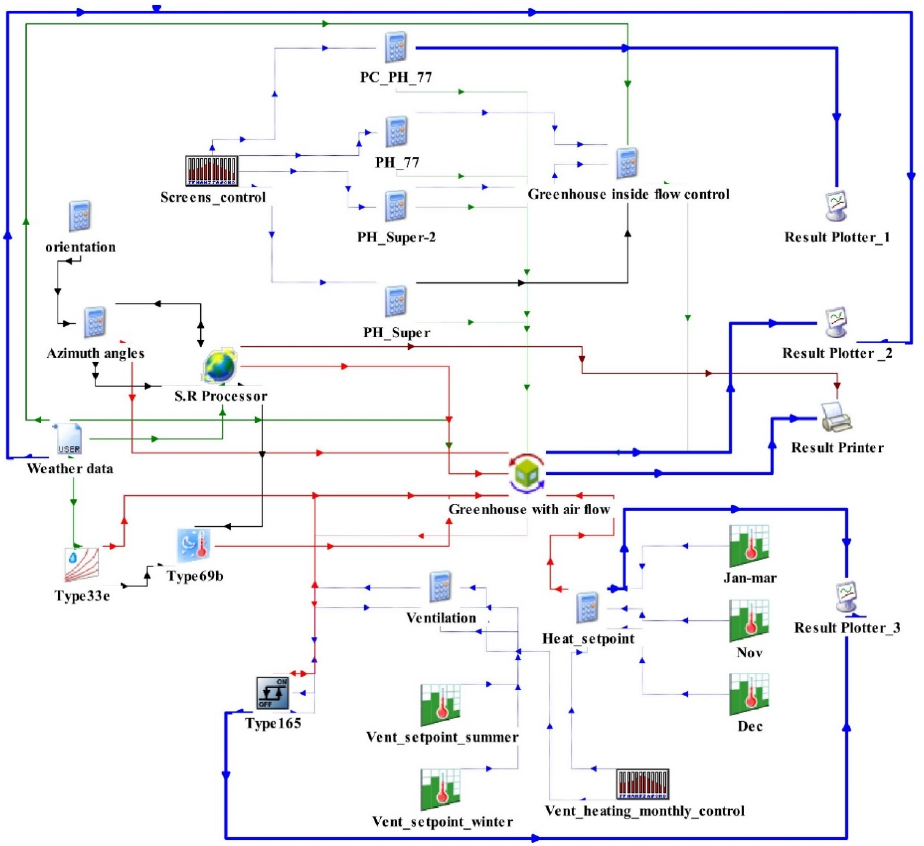
Figure 8. TRNSYS simulation studio multi-span greenhouse model. Table 4. Components of the greenhouse model in TRNSYS 18.